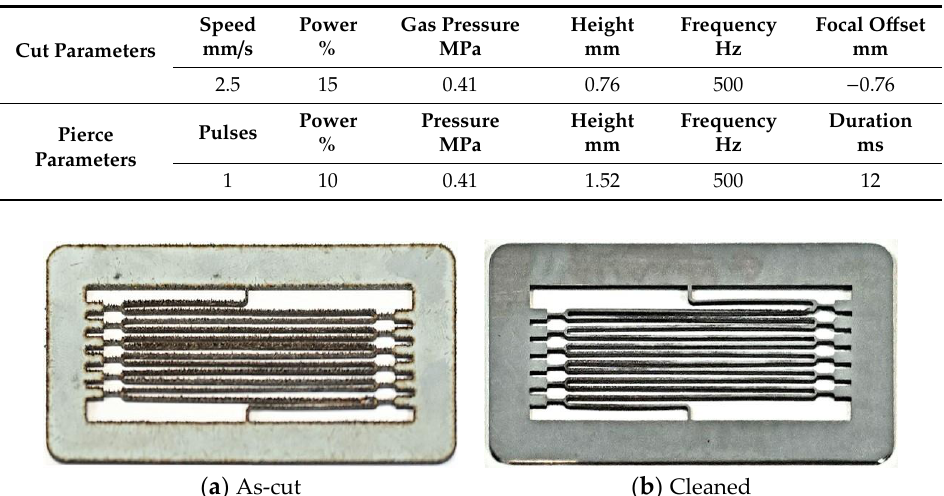
Table 1. Cut and pierce parameters of FabLight laser.